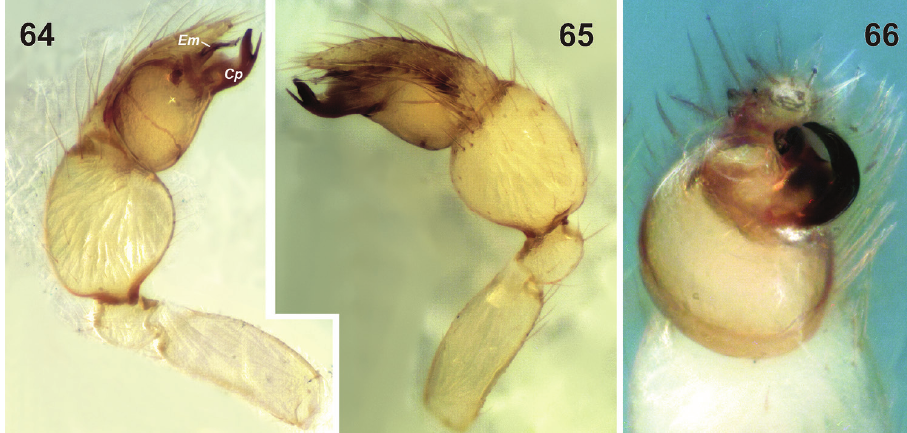
Figures 64–66. Male palp of Hybosidella etinde sp. n. 64 prolateral 65 retrolateral 66 antero-ventral. Abbreviations: Am accompanying membrane; Bl barbed tip of accompanying membrane; Cp claw-shaped process; Em embolus.